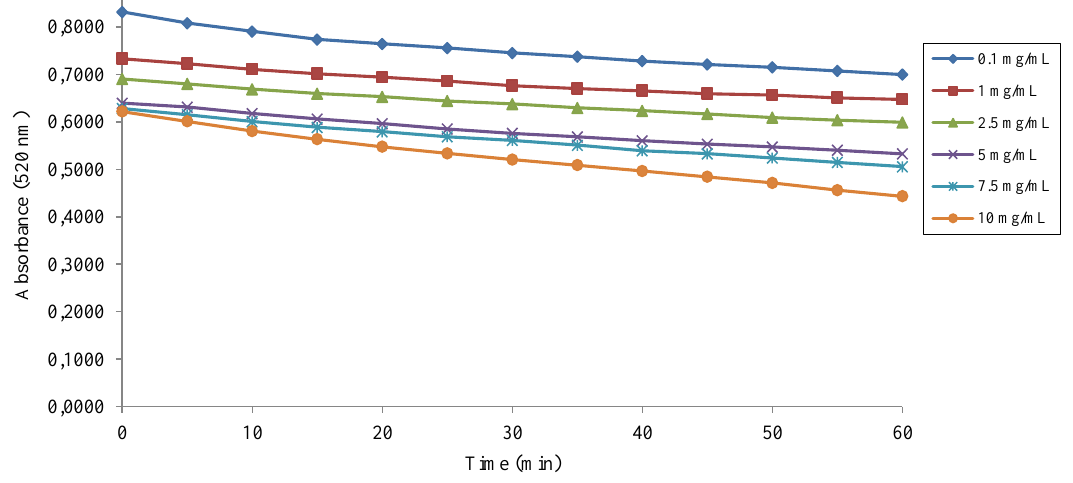
Figure 3. Kinetics of entrapment of DPPH• with respect to the concentration of the compound C2